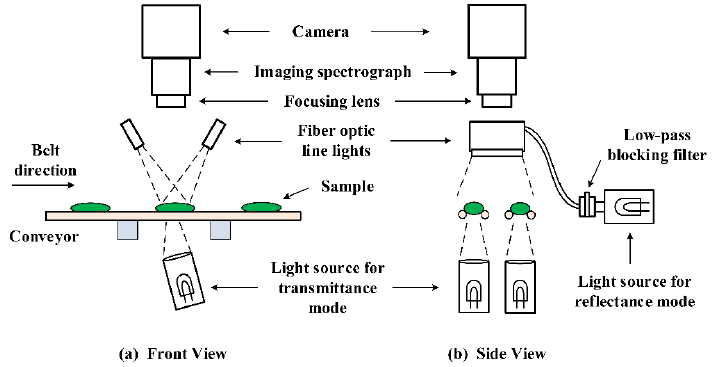
Figure 12. Schematic of a hyperspectral imaging prototype integrating reflectance and transmittance sensing modes. sensing